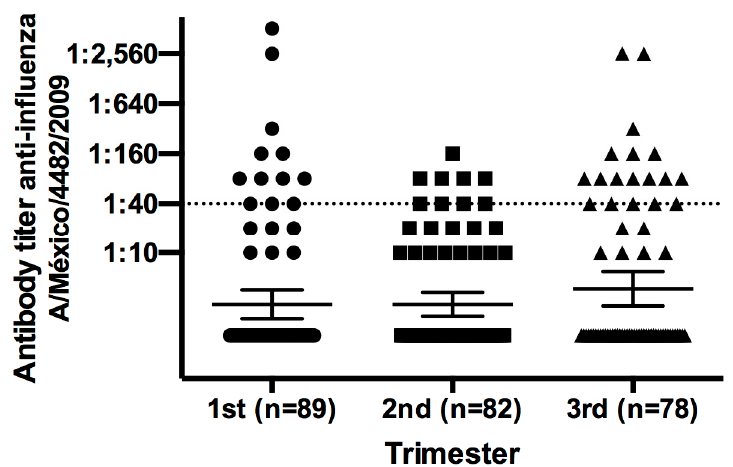
Figure 3. Protective antibody titer against pandemic influenza in healthy Mexican pregnant women. We collected 249 peripheral blood samples from healthy pregnant women who did not participate in the vaccination clinical trial—12 out of 89 women (13%) in the first trimester, 9 out of 82 (12%) in the second trimester, and 18 out of 78 (30%) in the third trimester had an antibody titer ≥ 1:40. Mean ± SD.